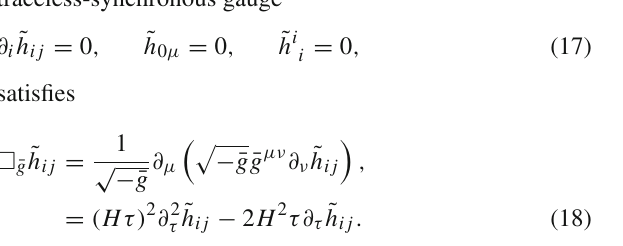
Fig. 1 Contour C that ensures causality, enclosing no poles for negative times. The branch cut is represented by the wavy line fluctuations are homogeneous, thus h μν ( x ) = h μν (τ) . The ˜ h μν = H 2 τ 2 h μν inthetransverse- rescaledperturbationfield